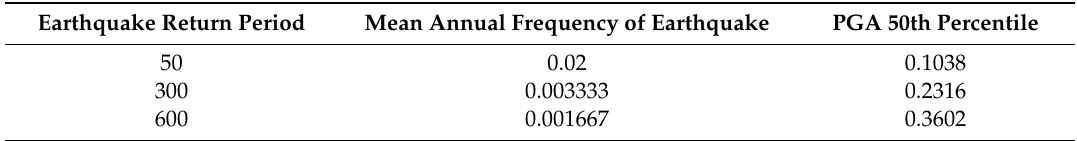
Table 7. Earthquakes characteristics for geographical location of L’Aquila (Source INGV [34]). Note: PGA is the peak ground acceleration on sti ff soil in terms of m / s 2 .